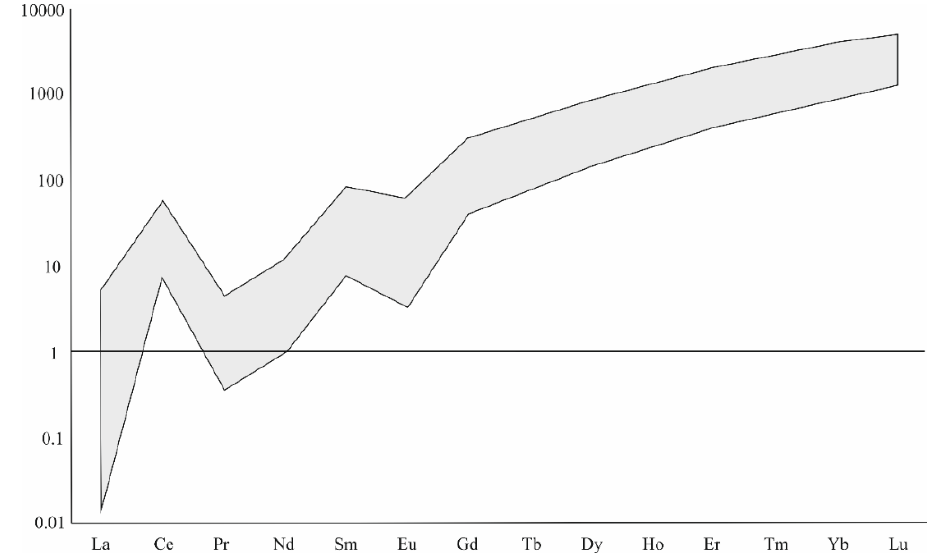
Figure 7. Range of REE content in the studied samples.